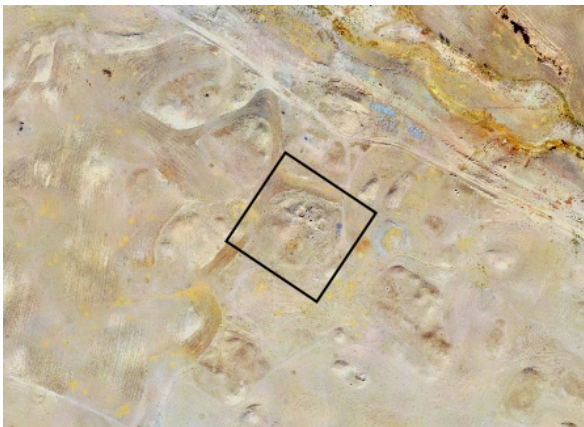
Figure 1. Makhmur al-Qadima site and processed defunct